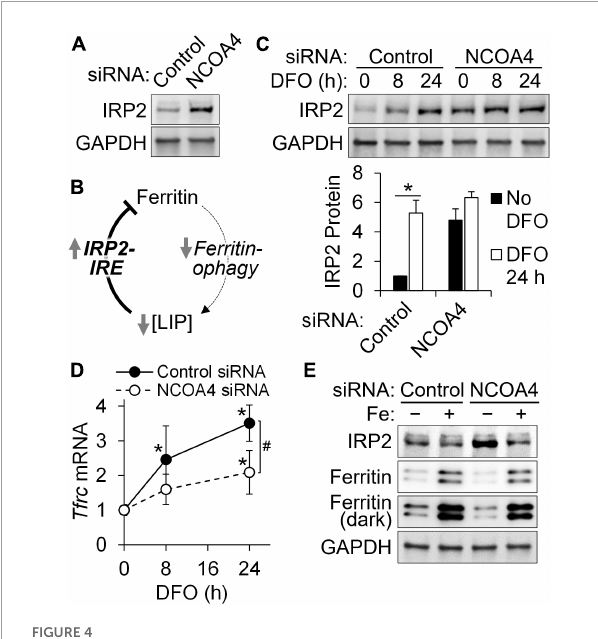
FIGURE4 NCOA4 depletion impairs the adaptive responses of iron genes to cellular iron restriction in HT22 cells. HT22 cells were treated with Ncoa4 siRNA to knockdown NCOA4 expression. (A) Accumulation of IRP2 protein by NCOA4 depletion. (B) Schematic model of IRP2-mediated ferritin repression by NCOA4 depletion. (C) Loss in IRP2 responses to iron restriction in NCOA4-depleted cells. DFO was added at 100 µ M. IRP2 quantitation was normalized to GAPDH. (D) NCOA4 depletion represses the responses of Tfrc mRNA to iron restriction (DFO, 100 µ M). Transcript abundance is relative to control siRNA-treated cells without DFO, and was normalized to that of Tbp . (E) IRP2 and ferritin remain responsive to supplemental iron in NCOA4-depleted HT22 cells. Iron was added as ferric ammonium citrate at 200 µ M for 24 h. Data in panels (C,D) are presented as mean ± SD, and are from n = 3–5 independent experiments. * P < 0.05 by DFO; # P < 0.05 by NCOA4 depletion. DFO, desferrioxamine; LIP, labile iron pool.